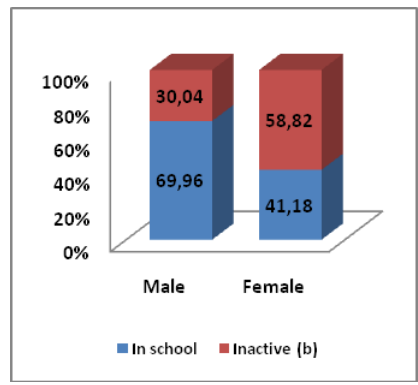
Source : TLMPS 2014 and authors’